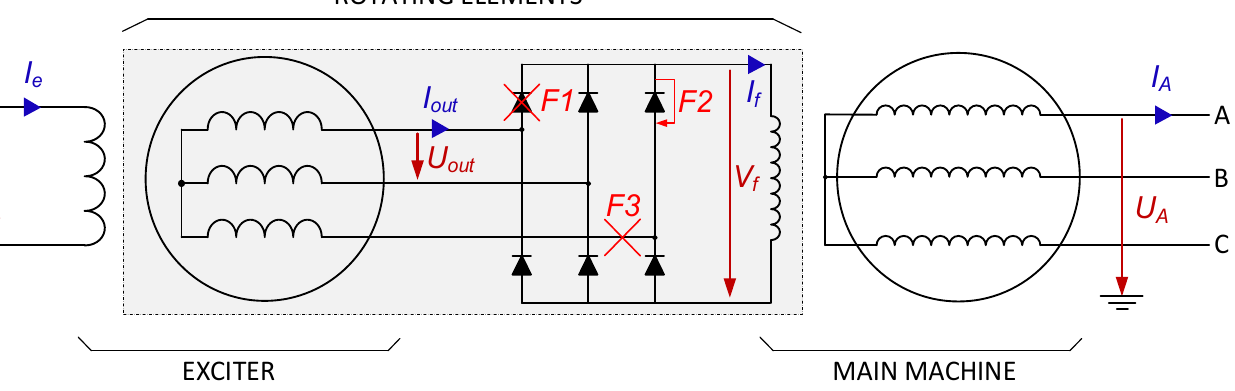
Figure 1. Simplified schema of the BSM (F1: open-diode fault; F2: shorted-diode fault; F3: open-phase fault).